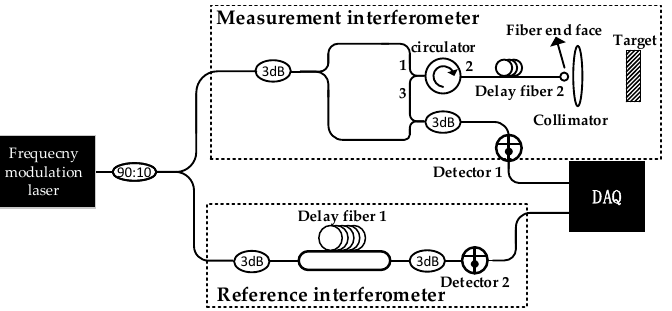
Figure 2. The system diagram of the dispersion compensation